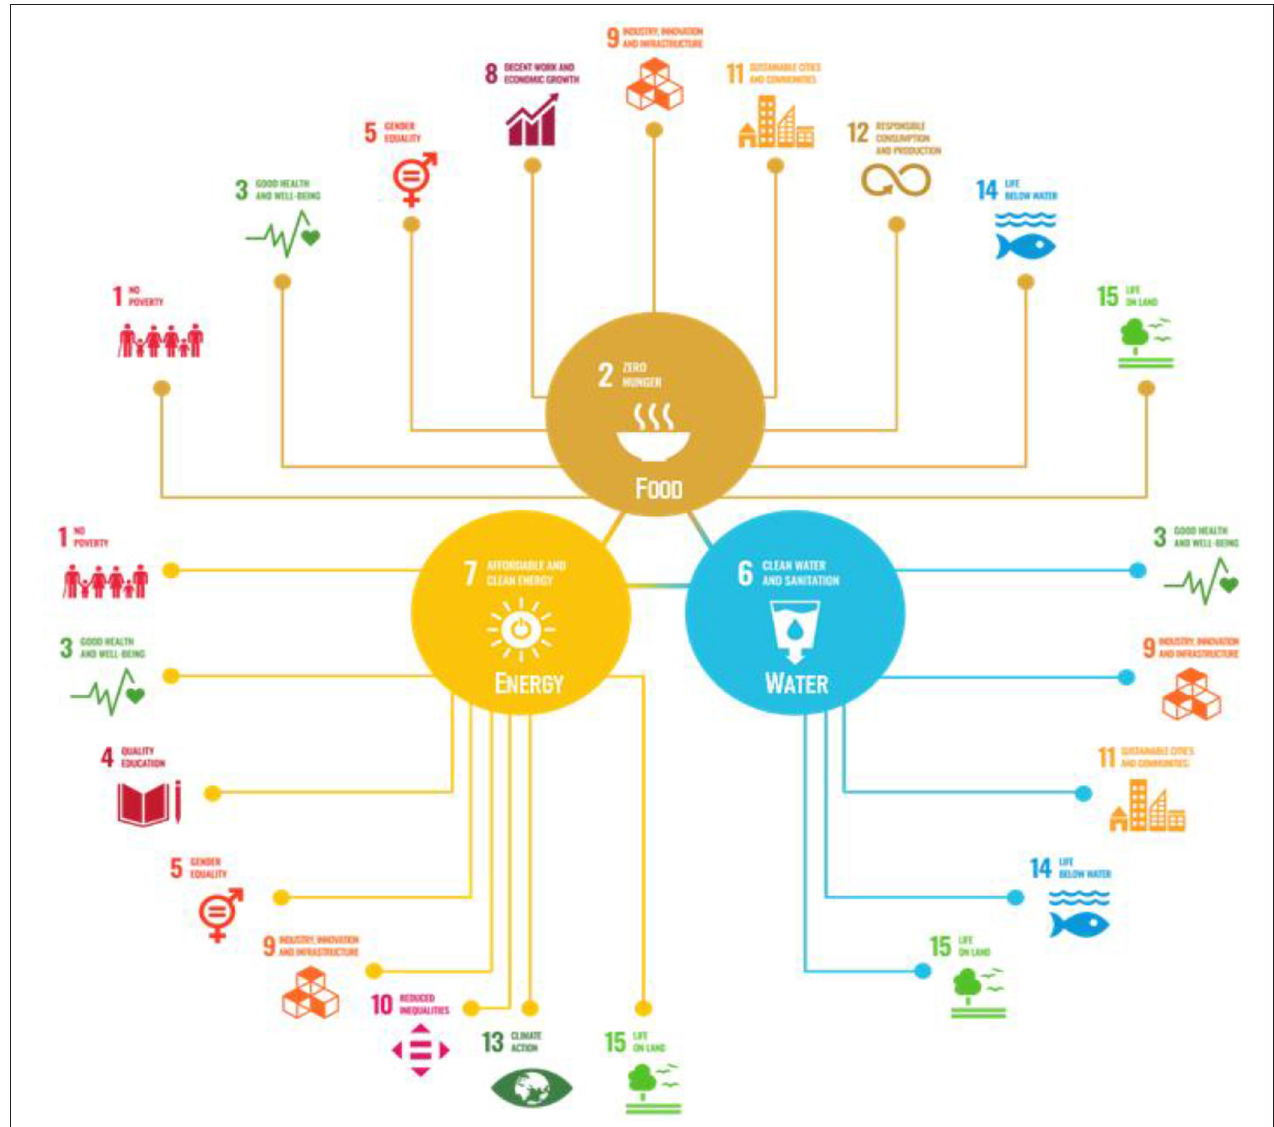
FIGURE 1 | Sustainable development goals in the context of the WEF nexus (author’s